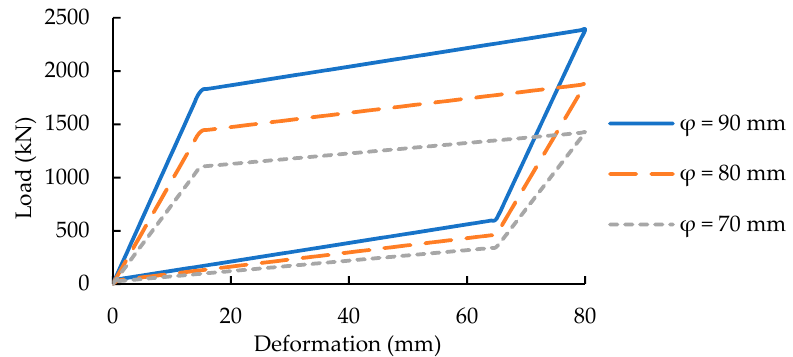
Figure 4. Hysteresis of each type of SC-TOB.